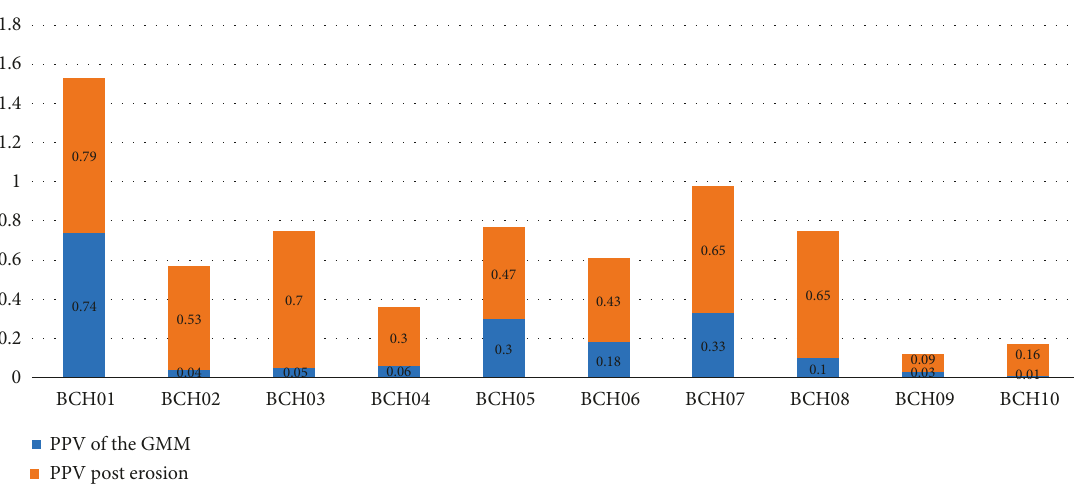
Figure 4: Comparison of PPV before and after application of erosion to the white matter